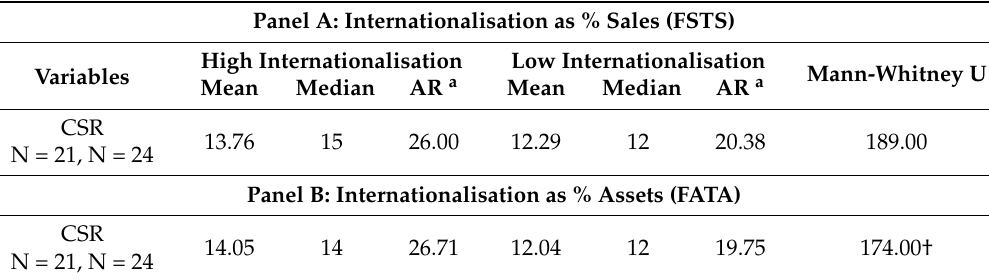
Table 4. Comparative analysis of CSR and Internationalisation (I).